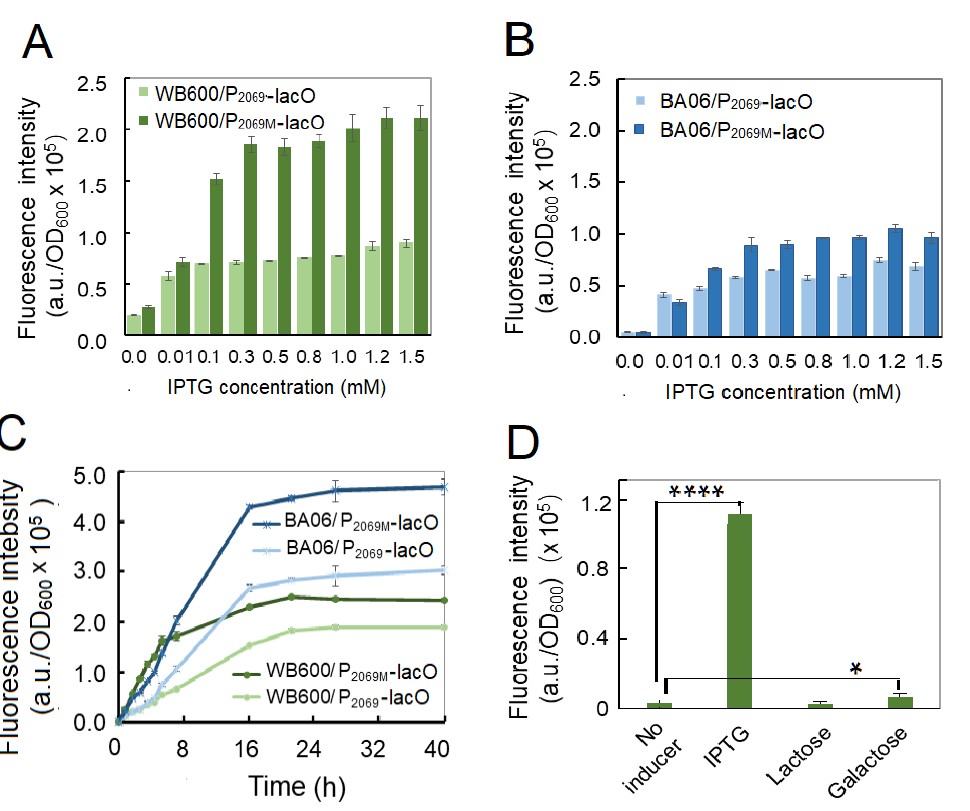
Figure 5. Optimization of the inducing parameters for GFP recombinant expression in Bacillus. ( A ) Optimization of IPTG concentrations in B. subtilis WB600 by induced for 4 h; ( B ) optimization of IPTG concentrations in B. pumilus BA06 by induced for 4 h; ( C ) optimization of inducing time in B. subtilis and B. pumilus ; ( D selection of the best inducer in B. subtilis .